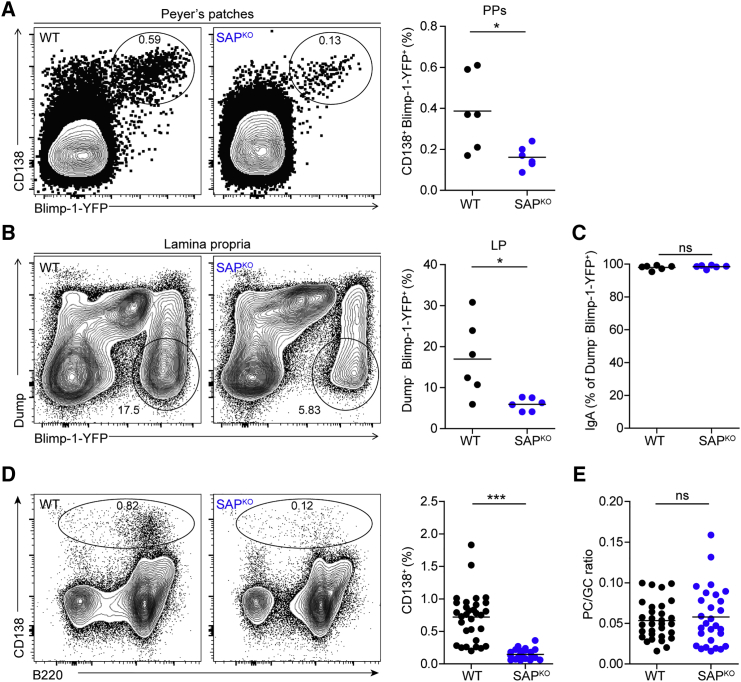
PC Generation in PPs Is Regulated by SAP in an Indirect Manner(A) Representative flow cytometry plots and quantification of Blimp-1+ CD138+ cell population in the PPs of WT and SAPKO Blimp-1-YFP reporter mice.(B) Representative flow cytometry plots and quantification of the Blimp-1+ Dump− (CD4+ CD8+ F4/80+ Gr-1+) cell population in the lamina propria of WT and SAPKO Blimp-1-YFP reporter mice.(C) Surface IgA frequency gated from the lamina propria Blimp-1+ cells shown in (B).(D) Representative flow cytometry plots and quantification of CD138+ cell population in PPs of WT and SAPKO mice.(E) Graph showing the ratio between the frequency of CD138+ cells to GC size in PPs of WT and SAP-deficient mice.In (A)–(C), data are pooled from two independent experiments with three mice in each experiment; line represents the mean. In (D) and (E), data are pooled from five independent experiments, with coupled CD138 and GC staining; line represents the mean. ∗p < 0.05, ∗∗∗p < 0.0001, two-tailed Student’s t test. ns, not significant.